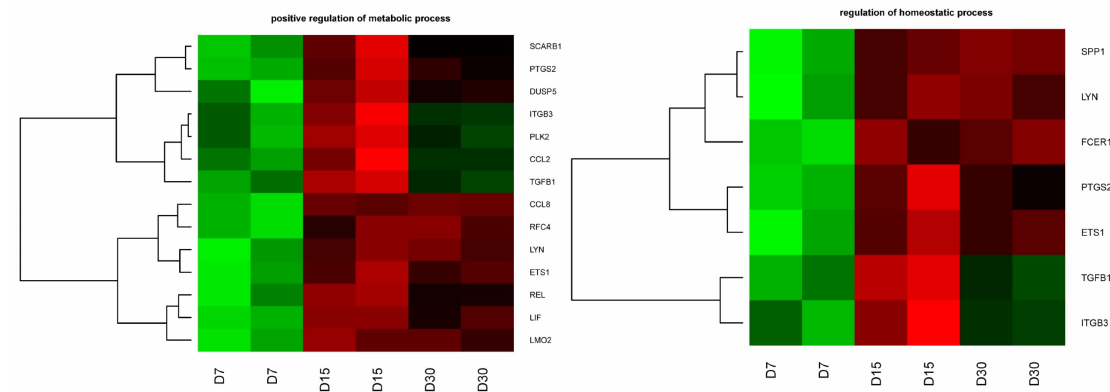
Figure 2. Heat map representation of differentially expressed genes belonging to the “positive regulation of metabolic process” and “regulation of homeostatic process”—GEOTERM BP database. Arbitrary signal intensity acquired from microarray analysis is represented by colors (green, higher; red, lower expression). Log2 signal intensity values for any single gene were resized to Row Z-Score scale (from − 2, the lowest expression, to +2, the highest expression for a single gene). Each analysis was run in two samples coming from different in vitro cultures of oral mucosal cells. Changes in transcript levels were analyzed between three time periods-Day 7(D7), Day 15 (D15) and Day 30 (D30), of primary culture. The fold change was calculated in relation to transcript levels at hour 24 of primary